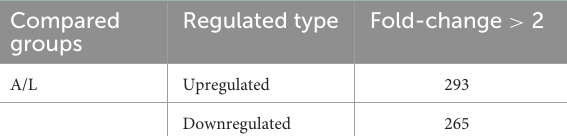
TABLE 2 Differentially expressed protein summary (filtered according to a threshold value of expression fold-change with a P -value < 0.05); A = adult, L =